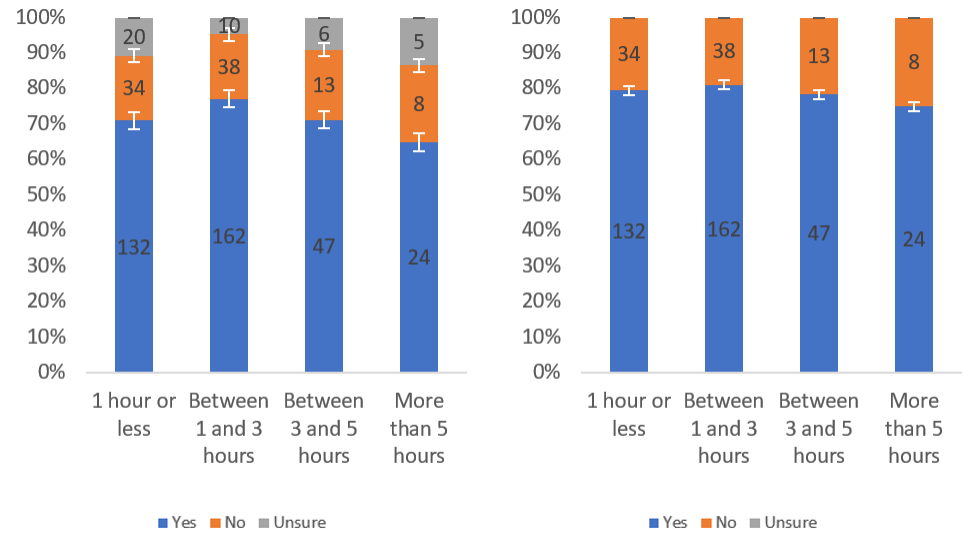
Figure 9. Responses regarding label helpfulness by internet usage level including ( left ) and excluding ( right ) unsure responses.